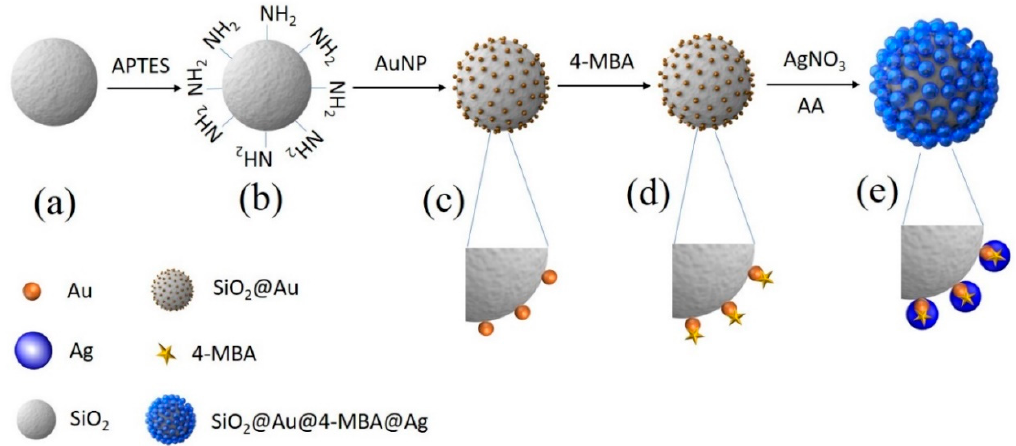
Illustration of preparation of Au@4-MBA@Ag embedded silica nanoparticles